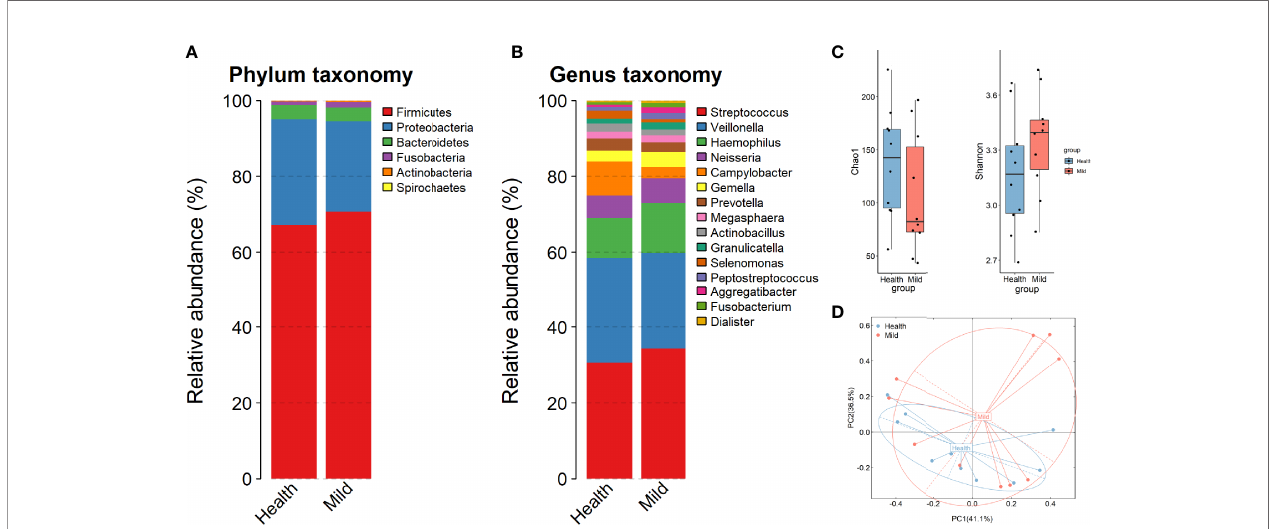
FIGURE 1 | Changes in microbial composition in mild COVID-19 patients compared to healthy controls. (A, B) Relative abundance of the top bacteria at the phylum and genus levels. (C) Chao1 diversity and Shannon biodiversity plot between healthy and SARS-CoV-2 (mild) individuals. (D) Bray – Curtis analysis of bacterial community composition diversity between healthy and SARS-CoV-2 samples.